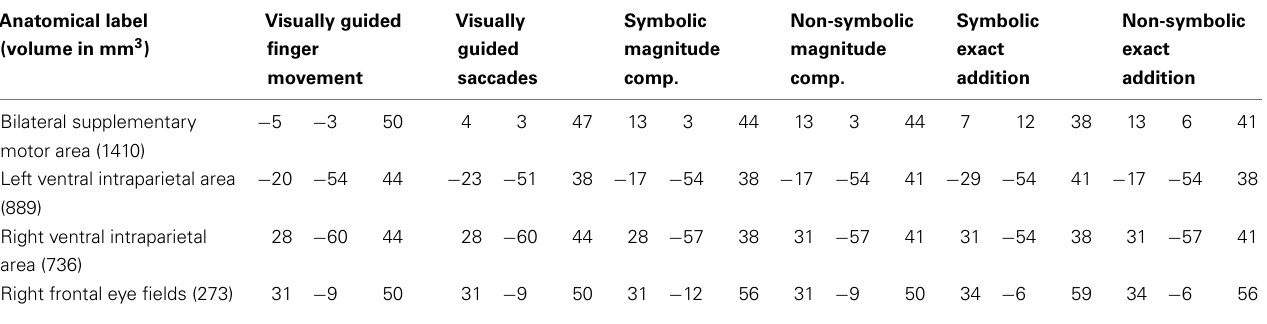
Table 2 |Anatomical labels and volumes in cubic millimeter of clusters significantly activated in all tasks (depicted in red in Figure 3) with respectiveTalairach coordinates ( x y z ) of peak values for all included